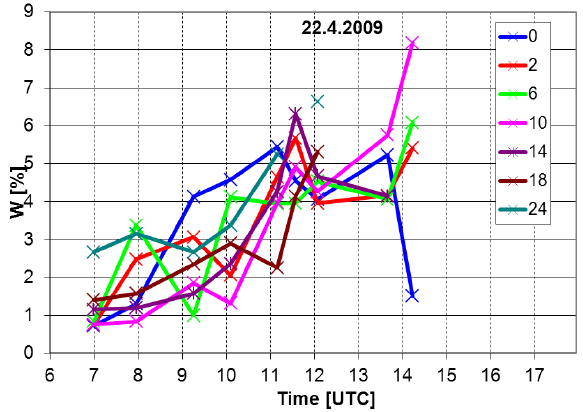
Fig. 7. The snow liquid water content on 22 April as a function of time and snow depth (0, 2, 6, 10, 14, 18, 24cm). The data shows that the water content first increased in the surface layer. Later, the water content was higher at deeper